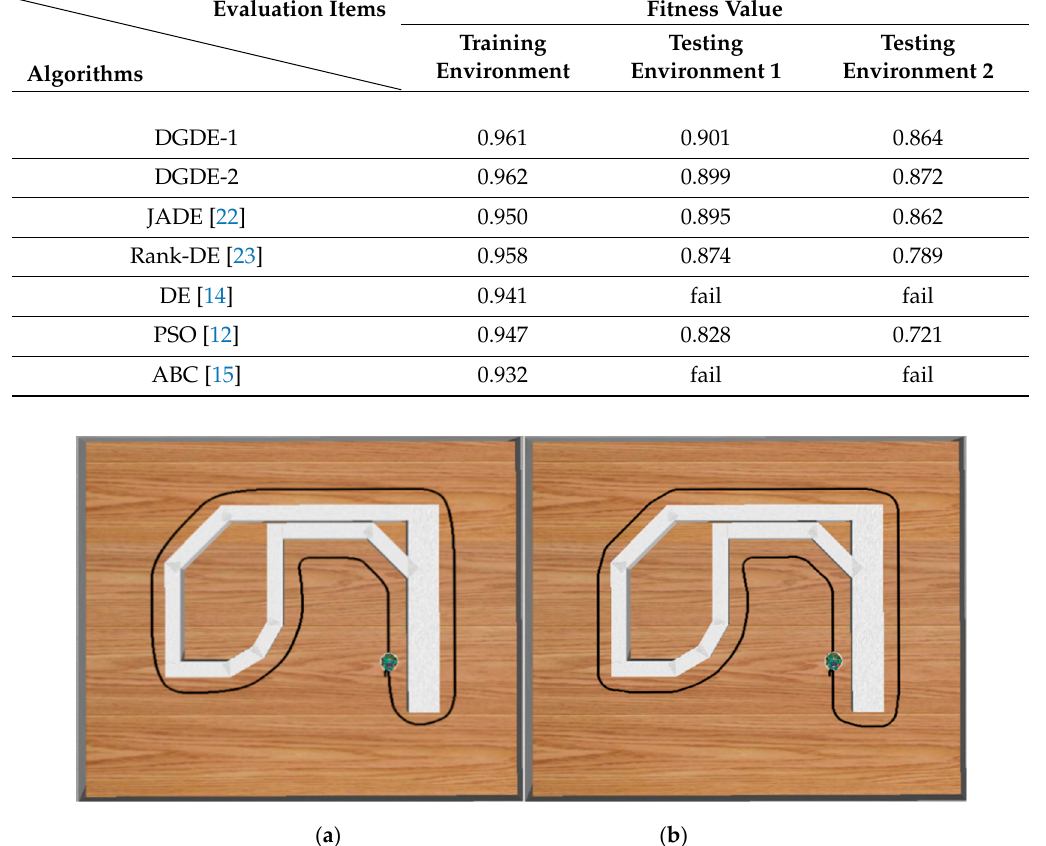
Figure 16. Moving path of the robot in the training environment: ( a ) DGDE-1 and ( b ) DGDE-2.